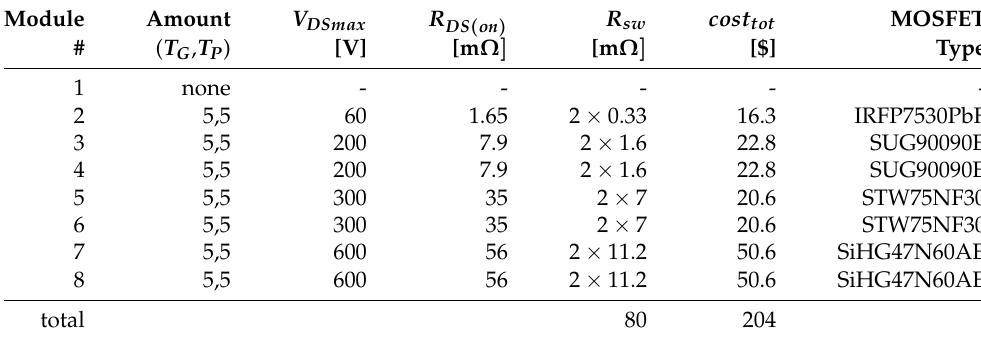
Table 1. Selection of discharging MOSFETs T G and T P with their adjacent typical R DS ( on ) , resulting in total module switch resistance R sw and cost.